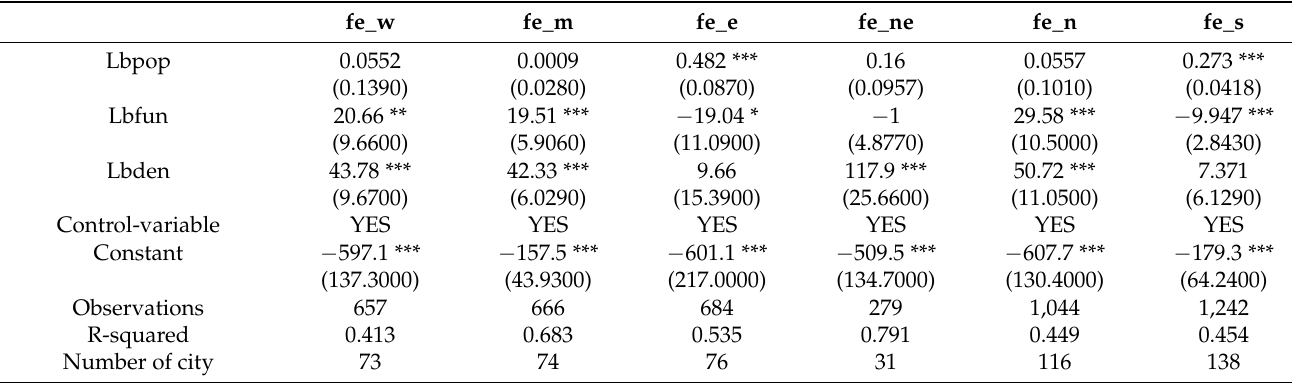
Table 2. Urban economic development by borrowing size divided into the four traditional major plates and the southern and northern